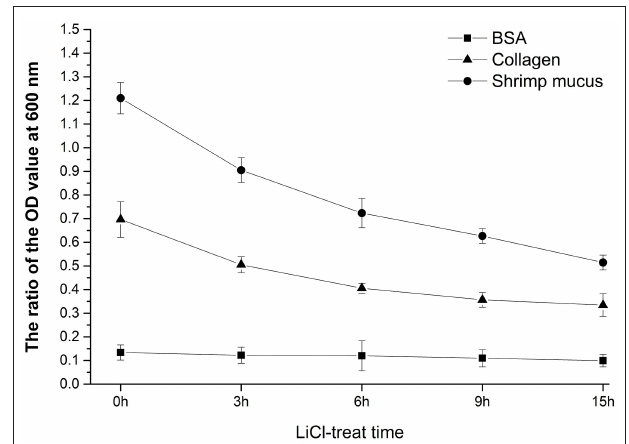
FIGURE 9 | The adhesive rate is presented by the ratio of the fluorescence absorption value at 500nm of adherent bacteria to initial bacteria. The adhesive activity of LiCl-treated L. plantarum HC-2 to bovine serum albumin (BSA), collagen, and crude mucus of L. vannamei . Results are mean ± standard deviation for three experiments (three replicates per experiment).